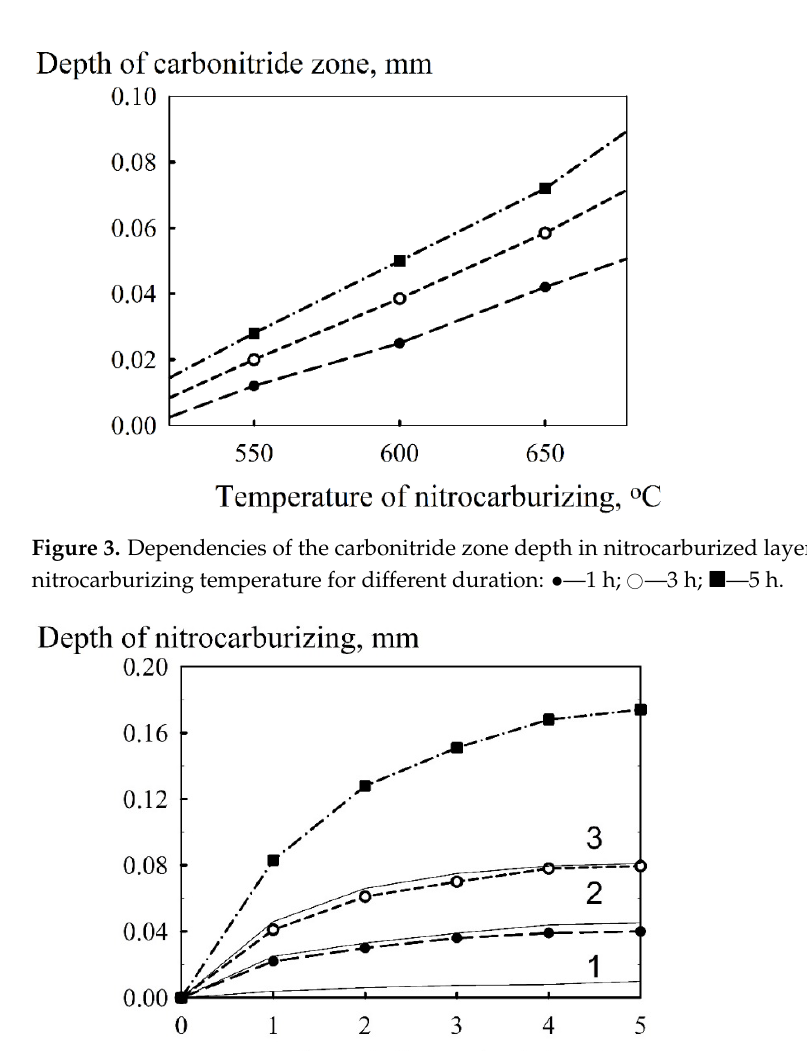
Figure 4. Dependences of the depth of nitrocarburizing steel 60Si2Cr on the duration of the process at di ff erent temperatures: ● and 1—the total depth of the diffusion layer and the depth of the car- bonitride zone, respectively, temperature 550 °C; ○ and 2—temperature 600 °C; ■ and 3—tempera- ture 650 ° С .